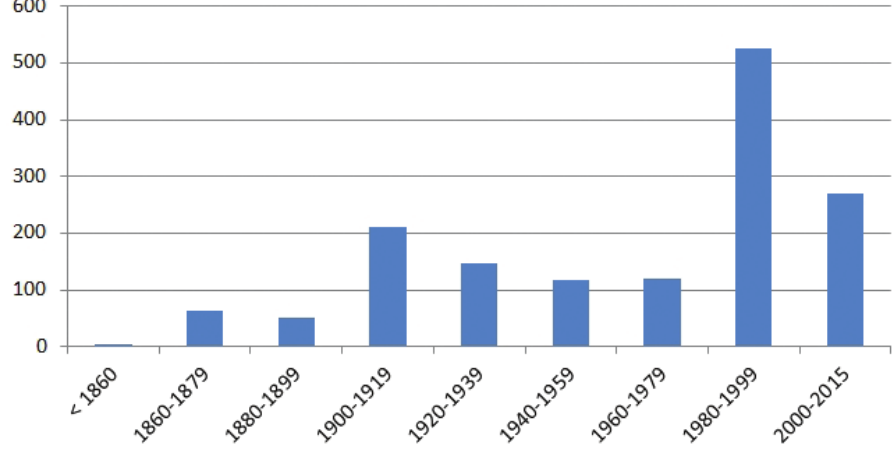
Figure 7. Collecting years according the specimens